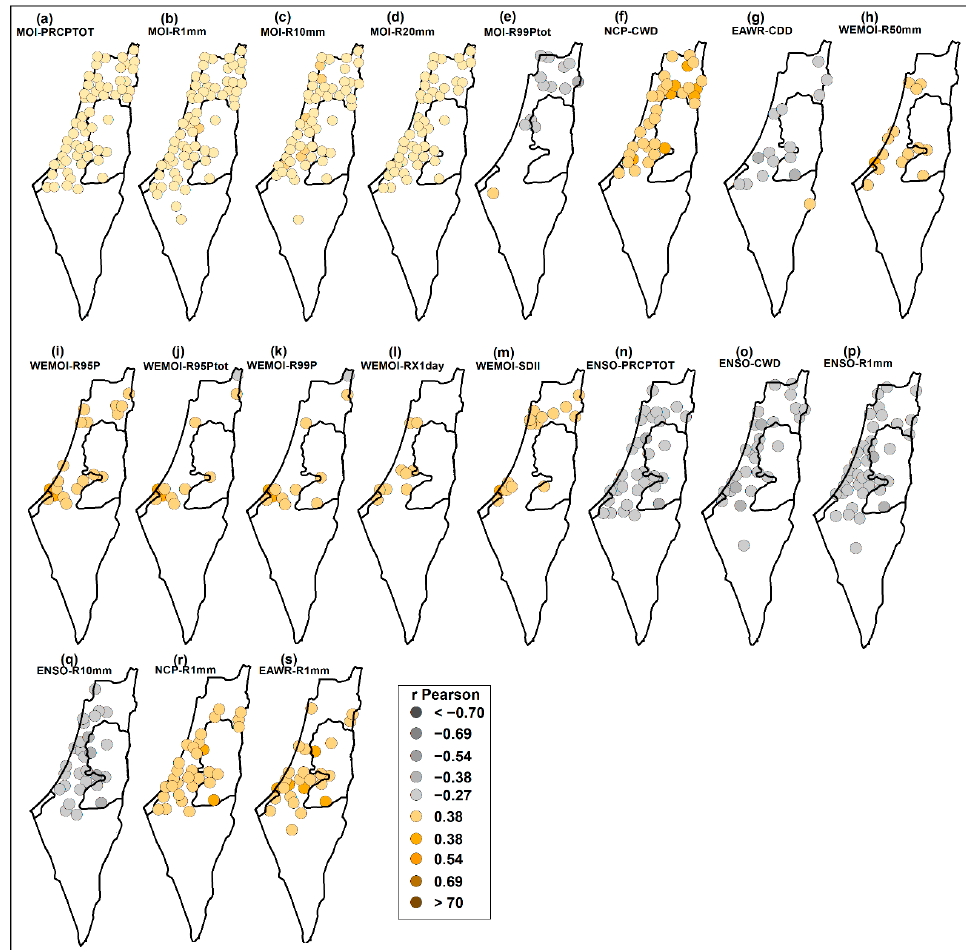
Figure 6. Spatial distribution of significant Pearson correlation coefficients between the teleconnec- tion indices (MOI, NCP, EAWR, WEMOI, and ENSO) and the extreme precipitation indices (PRCPTOT, R1mm, R10mm, R20mm, R99Ptot, CWD, CDD, R95P, R95Ptot, R99P, RX1 day, and SDII), at annual